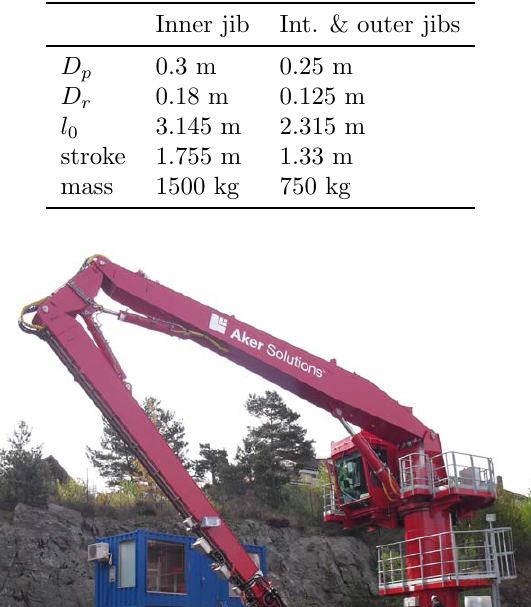
Table 6: Cylinder model parameters.